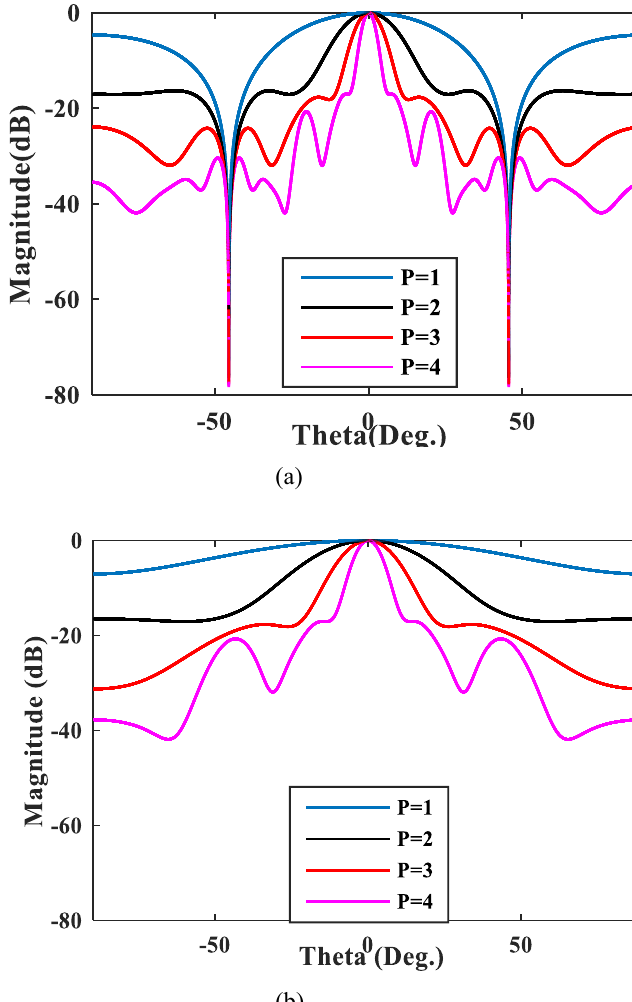
Figure 5. Array factors of linear fractal array antennas generated by concentric (a) elliptical and (b) circular ring sub array generators for S=2 up to four